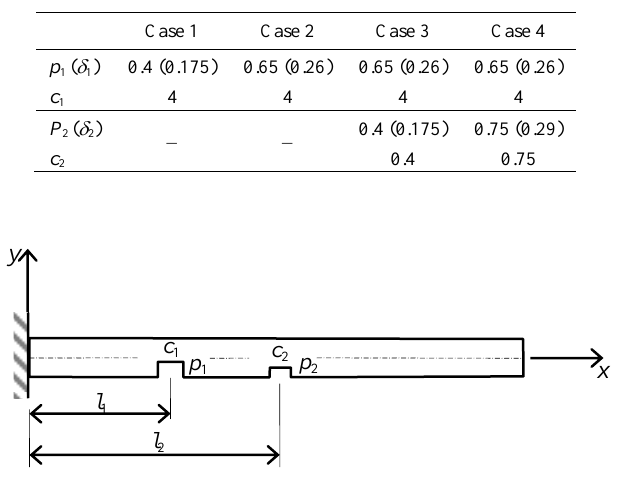
Fig. 1. Clamped-free aluminum beam with two cuts